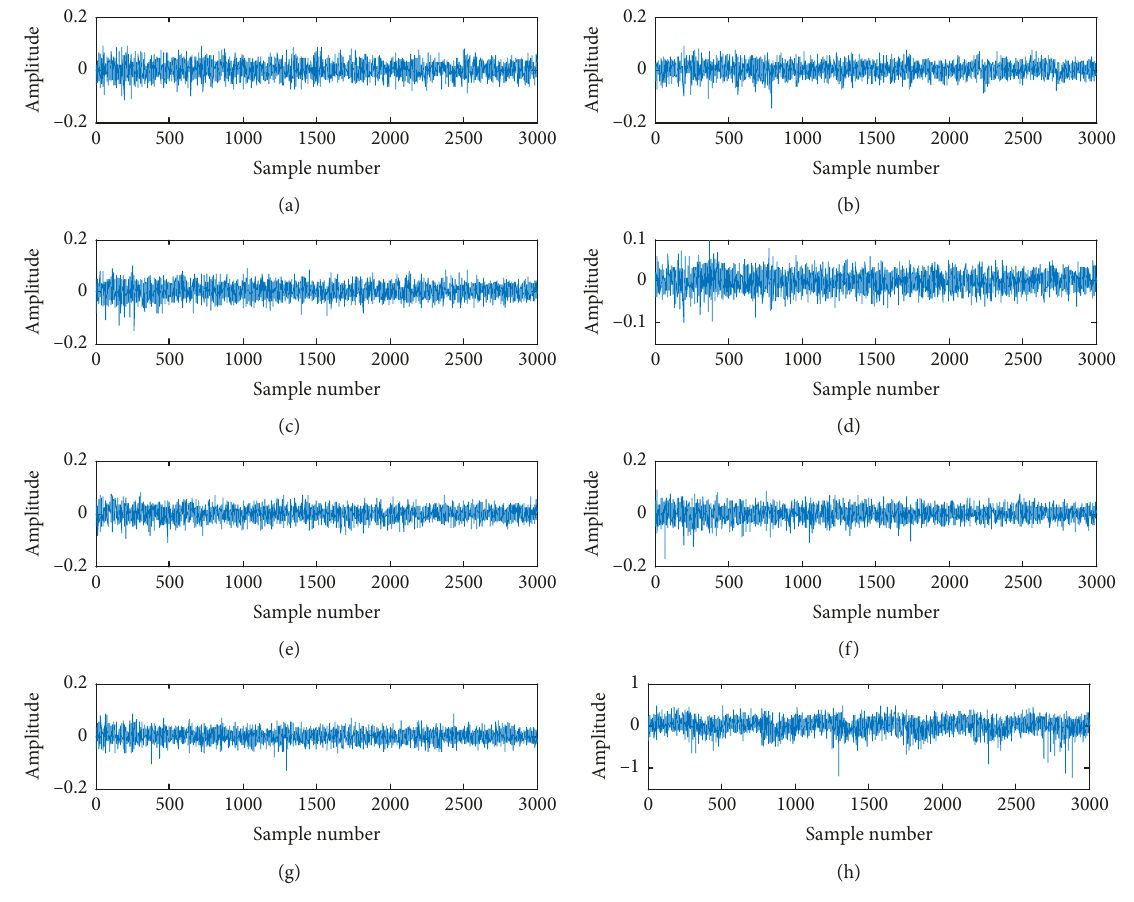
that represents the fourth layer slow ij DMD , X , X , X , X , X , X , and X , respectively. The symbols in 41DMD 42DMD 43DMD 44DMD 45DMD 47DMD 48DMD 46DMD